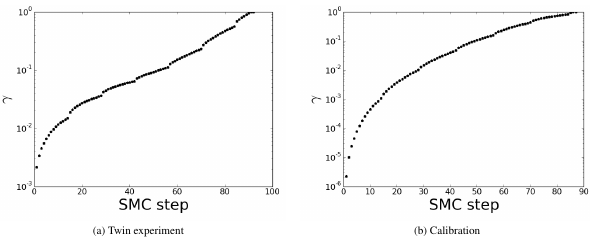
Figure 1. Adaptation of γ t for the twin experiment (a) and the cal- ibration (b) . The small jumps indicate the locations where resam- pling